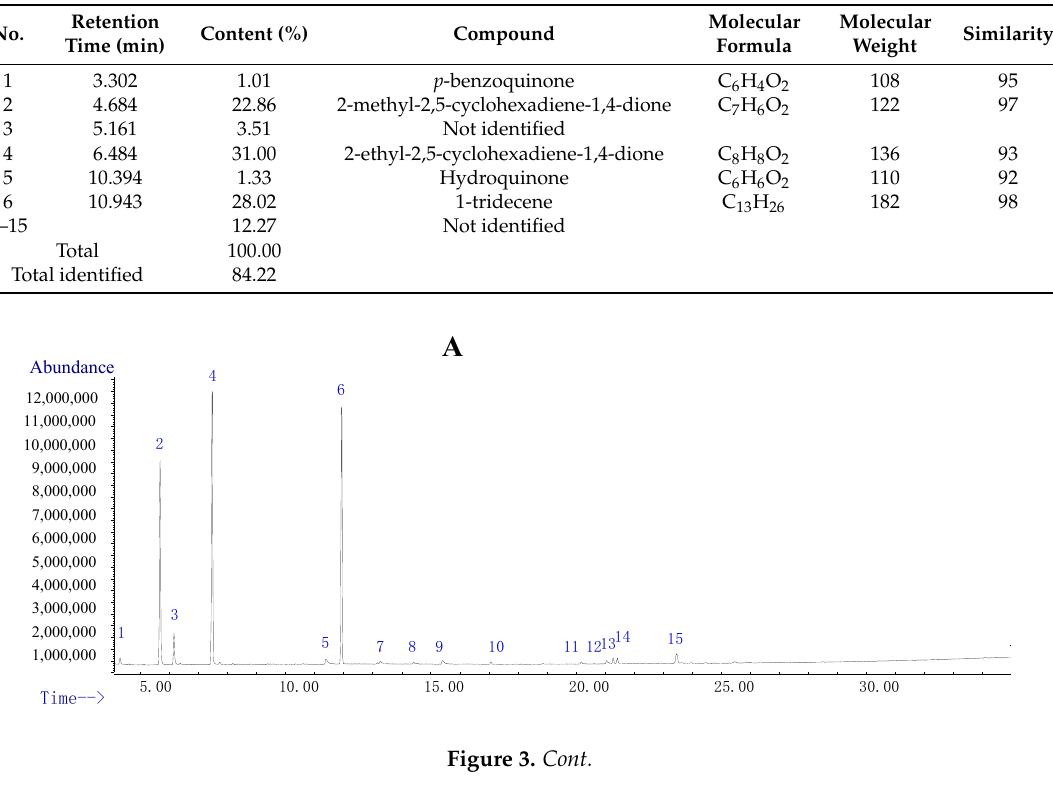
Table 2. Possible components in the defensive secretion of B. rynchopetera .